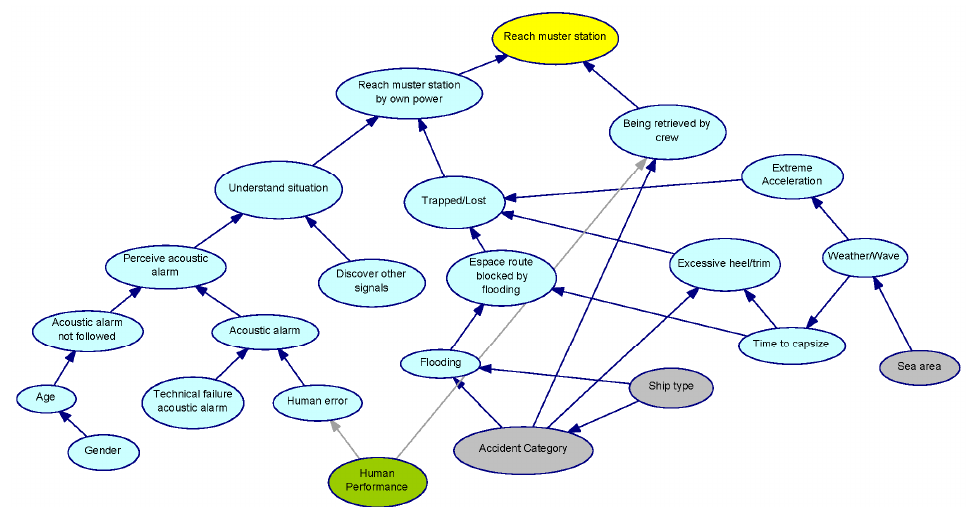
Figure 5. Bayesian network for the mustering process in flooding accidents (02 FL ).